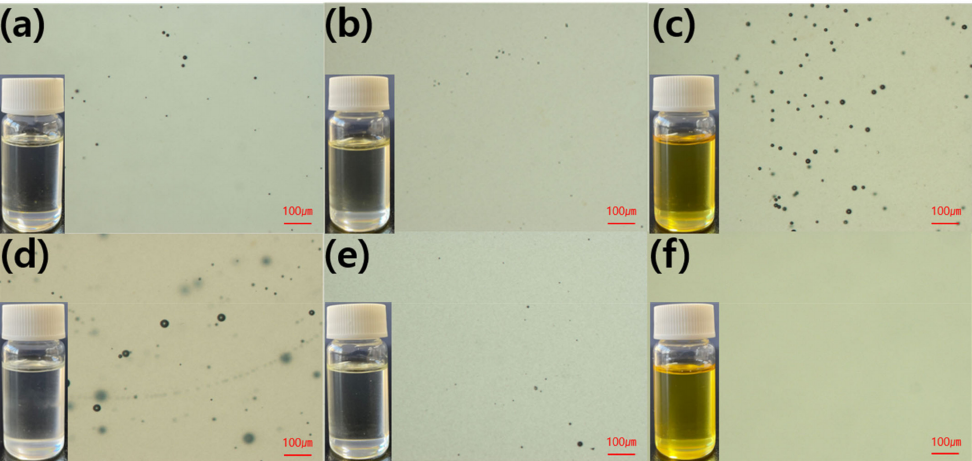
Figure 11. Optical microscope images of the epoxy mixtures: ( a ) DGEBA/PBP; ( b ) DGEBF/PBP; ( c ) TGAP/PBP; ( d ) DGEBA/SPB; ( e ) DGEBF/SPB and ( f )